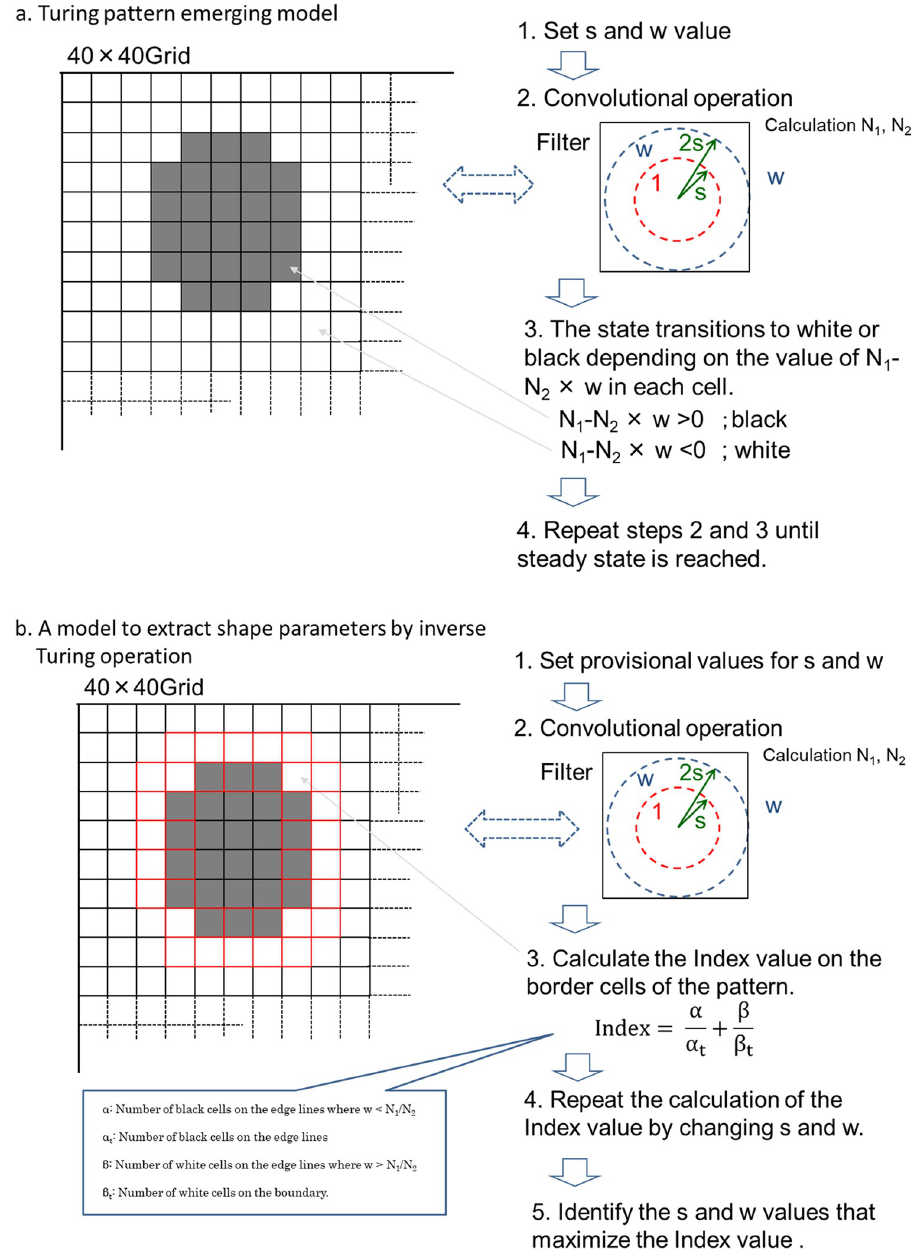
Fig 6. Diagram of pattern emergence calculation and its inverse calculation process. (a) The specific pattern emergence model by filter convolution calculation from two parameters, s and w. (b) The parameters s and w by the inverse calculation